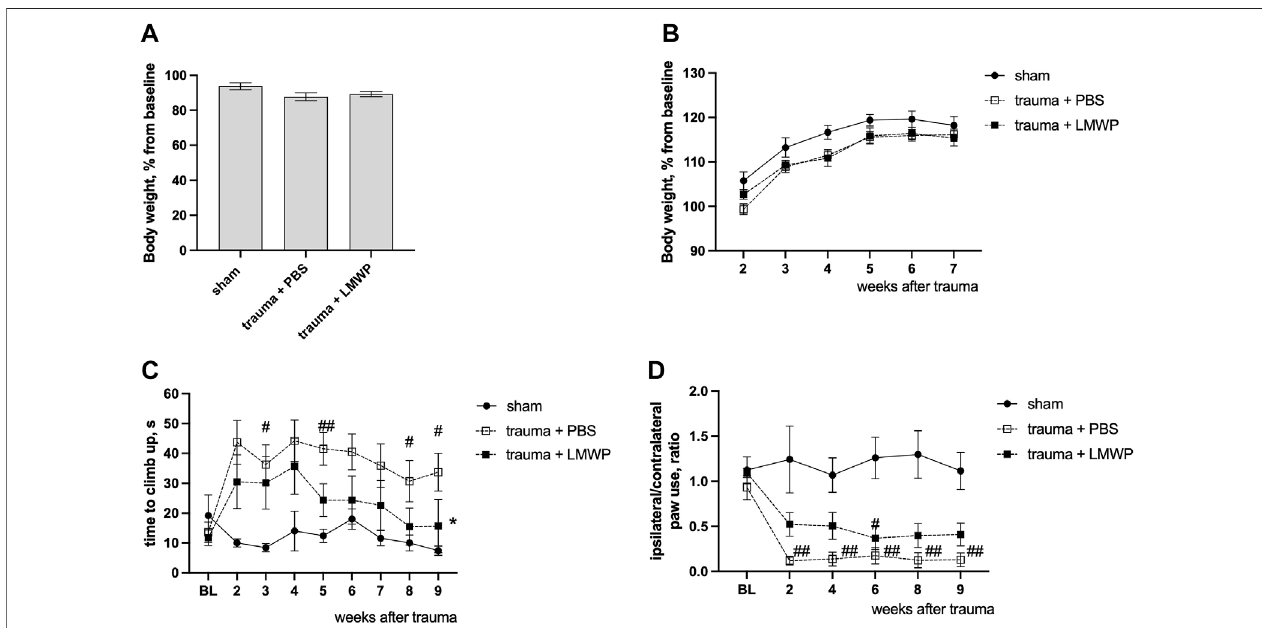
FIGURE 6 | Functional outcomes of LMWP treatment delivered through the intracerebroventricular (ICV) route in the mouse cervical hemisection model. (A) The body weight of animals on the day 3 after the trauma before the start of the treatment. (B) The change of body weigh during the follow-up behavioral tests. (C) The LMWP-treated group demonstrates progressive improvement ofclimbingfunctioninthe vertical screentest. (D) Themice treatedwithLMWPdemonstrate reduction of front paw use asymmetry at the weeks 2, 4, 8 and 9 after the trauma. # p < 0.05, ## p < 0.01 Kruskal-Wallis test with Dunn ’ s versus sham group; * p < 0.05 Kruskal- Wallis test with Dunn ’ s post-hoc pair-wise comparison versus the PBS-treated group; n = 5 – 10.